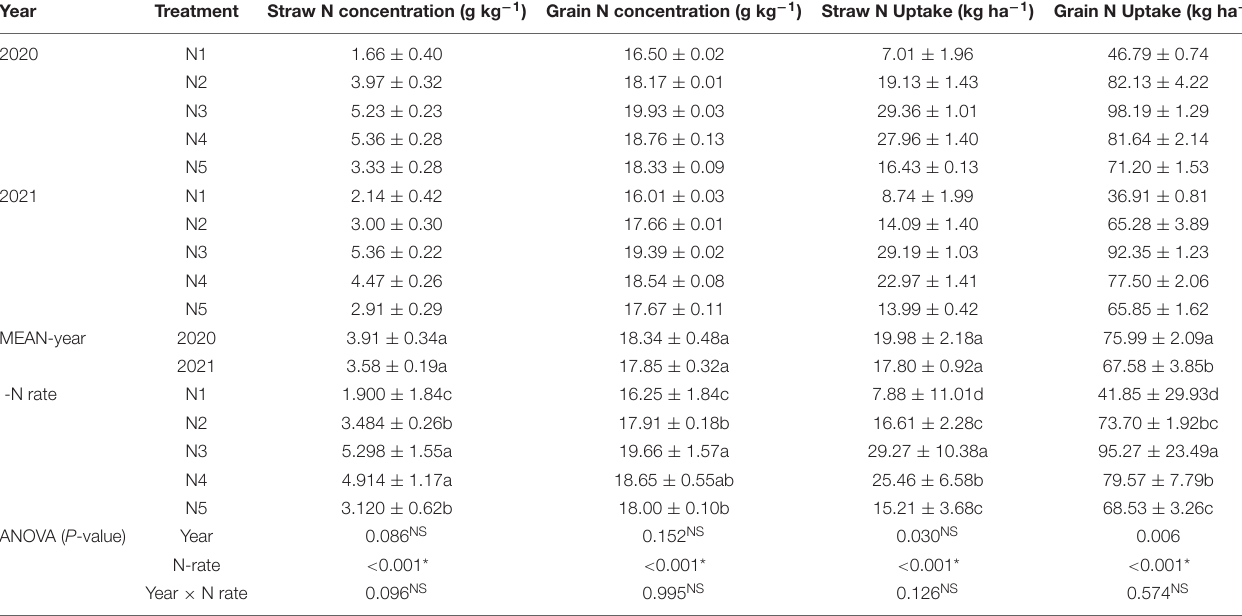
TABLE 3 | Effects of N fertilizer rate on N accumulation and uptake in grain and straw of spring wheat cultivar. Year